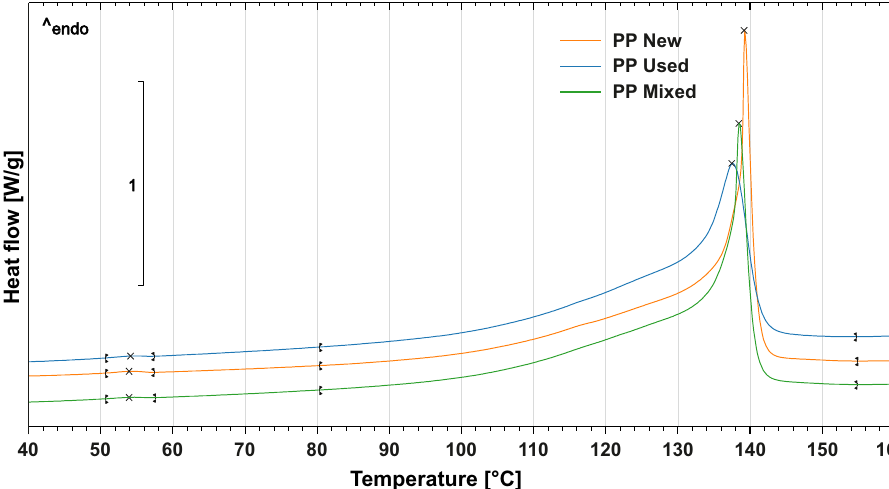
Figure 4. Melting point of (new, used, mixed) PP